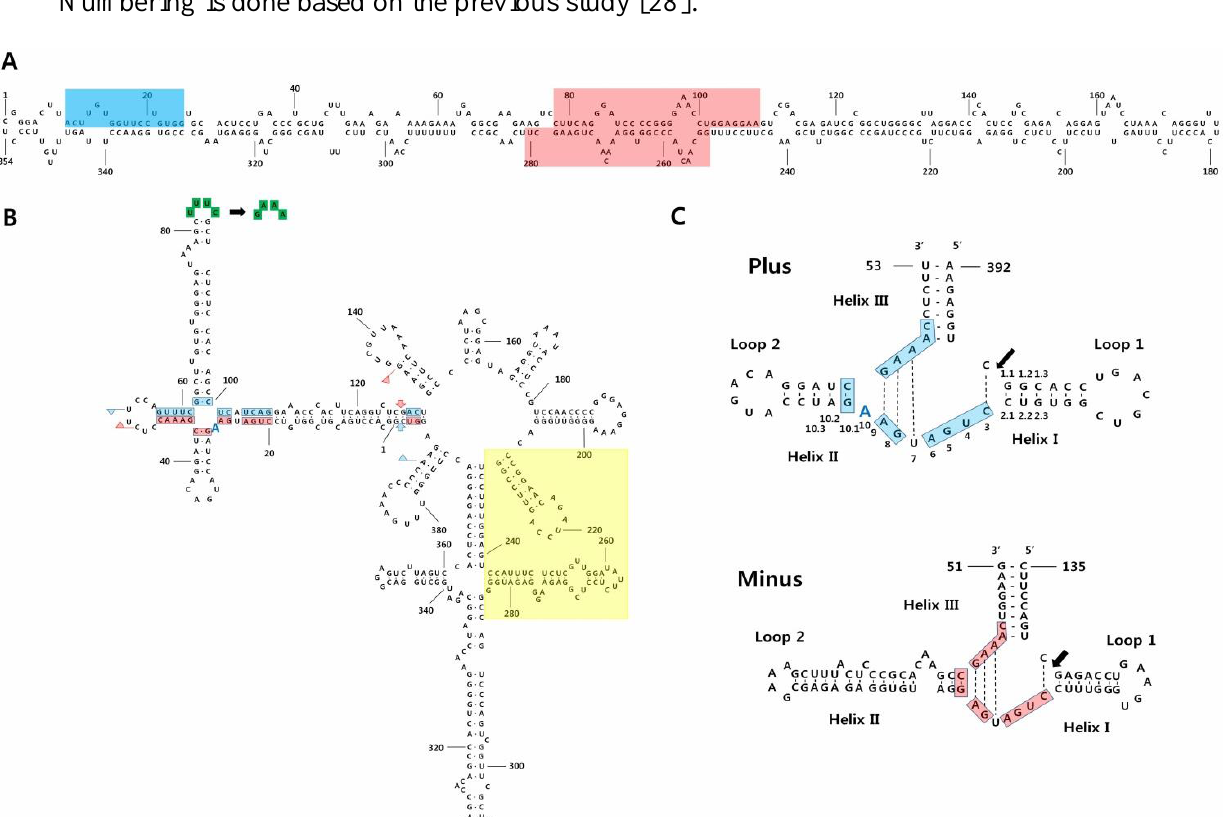
Figure 1. Predicted secondary structures of CSVd and CChMVd. ( A ) Predicted secondary structure of CSVd was adapted with permission from [22]. The central conserved region (CCR) is indicated by light-red shading and the terminal conserved region is indicated by light-blue shading; ( B ) Predicted secondary structure of CChMVd was adapted with permission from [28]. Plus and minus self-cleavage domains are delimited by flags, residues conserved in most natural hammerhead structures are boxed, and the self-cleavage sites are indicated by arrows. Light-blue shading and light-red shading in flags, boxes, and arrows refer to plus and minus polarities, respectively. The changes in the tetraloop delimited by positions 82–85 (UUUC to GAAA) that convert a symptomatic variant into non-symptomatic are shown with green-colored boxes [29]. The light-yellow square demarcates the domain that alternatively can form a kissing-loop interaction [30]; ( C ) Hammerhead structures of the plus and minus strands of CChMVd were adapted with permission from [28]. Residues conserved in most natural hammerhead structures are on light-blue shading and light-red shading in the plus and minus polarities, respectively, and the self-cleavage sites are indicated by arrows. Blue colored A indicates the position of the extra A in the CChMVd secondary structure and in its plus hammerhead structure. Numbering is done based on the previous study